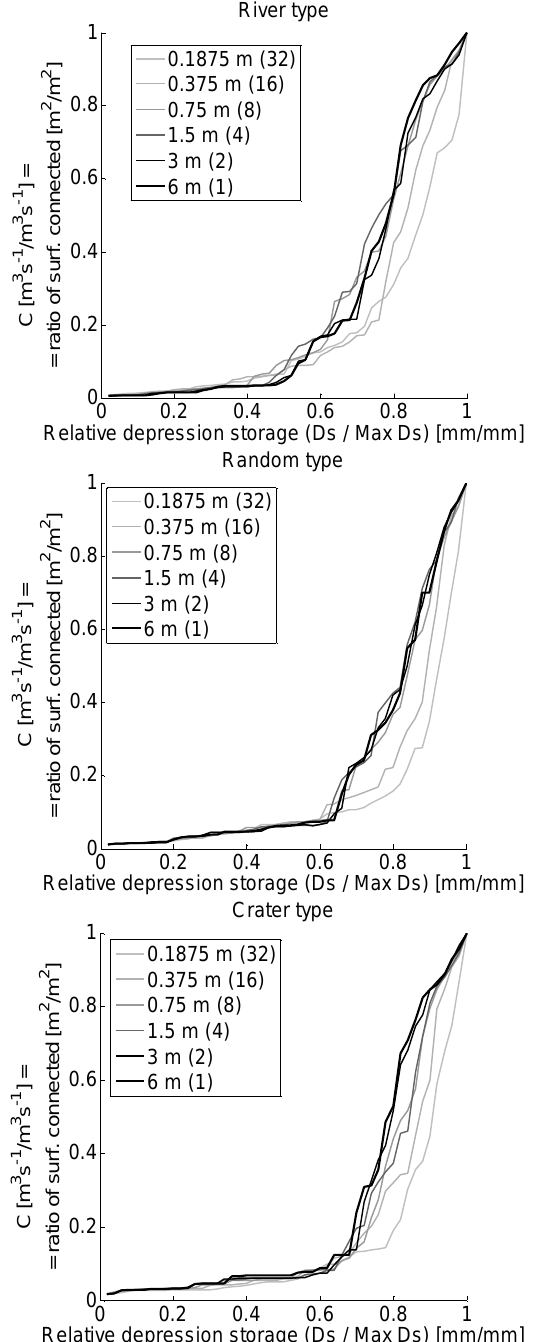
Fig. 10. Synthetic fields – effect of plot width on the average nor- malized RSC function for the river, random and crater type micro- topographies. Depression storage (x-axis) was scaled by the maxi- mum depression storage. The numbers in parentheses indicate the number of connectivity curves used for calculating the average nor- malized RSC functions. All plots are 6m